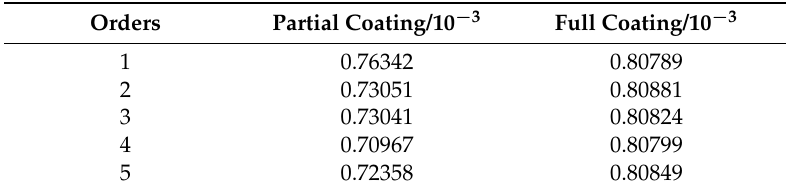
Table 5. Comparison between the damping optimization results for the first order and the results corresponding to the full coating structure.